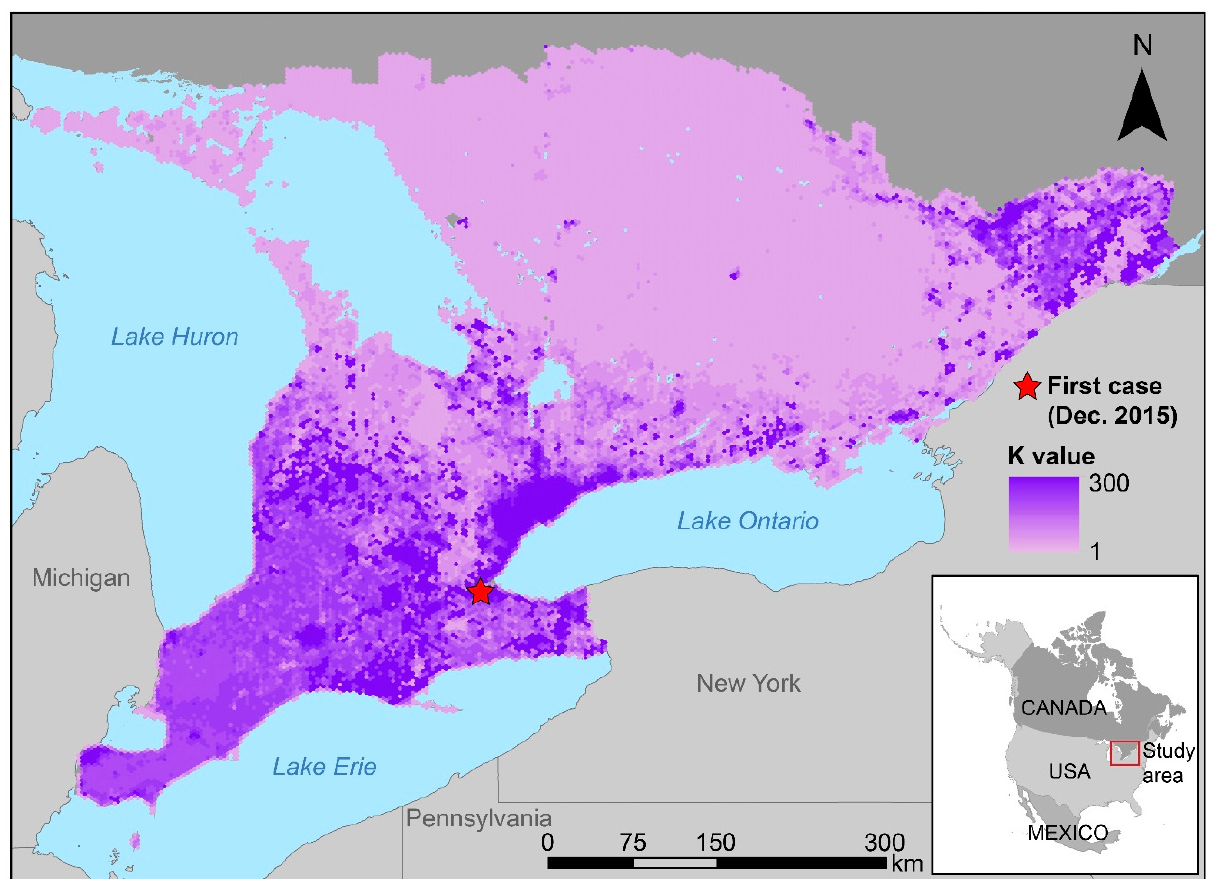
Figure 1. Map of the study area of Southern Ontario with K values shown with the location of the first detected raccoon rabies case. K values represented the predicted number of raccoons sustained by the habitat in each 10-km 2 grid cell. A red star denotes the location of the first detected case of raccoon rabies in December 2015. The red square in the inset map denotes the study area.